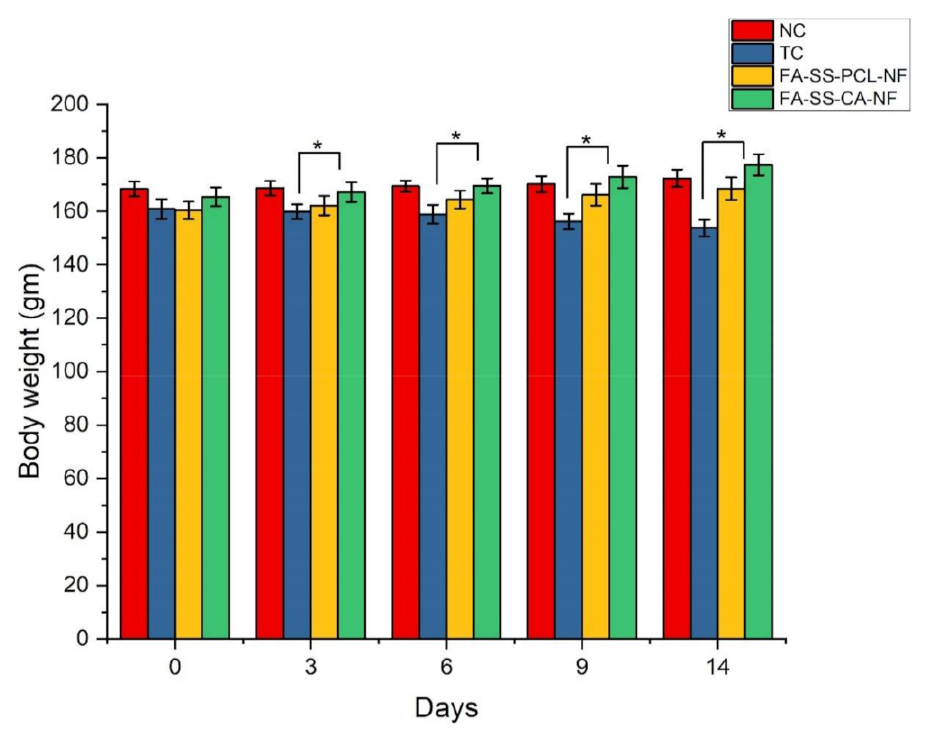
Figure 13. Quantitative result of the effect of diabetes on body weight in diabetic rats (mean ± S.D). * Significant differences between control and the